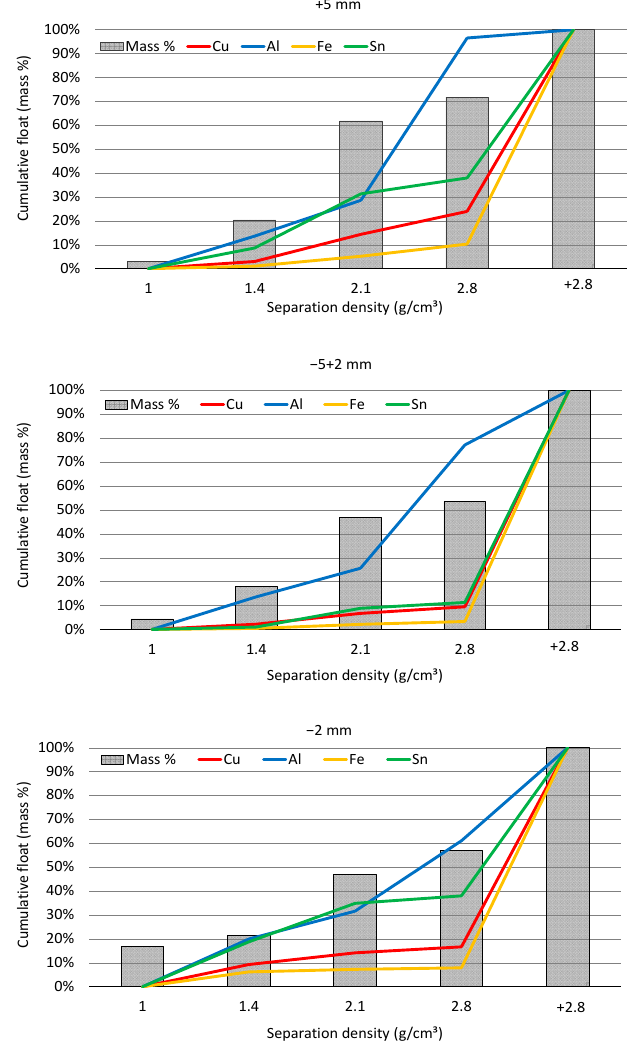
Figure 5. Density distribution curves for the different size ranges analyzed.